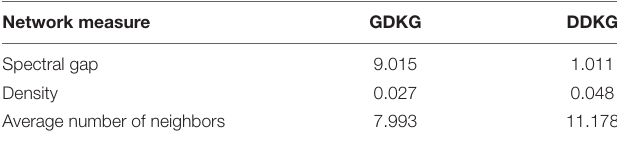
TABLE 7 | Network measures for the GDKG and DDKG networks.